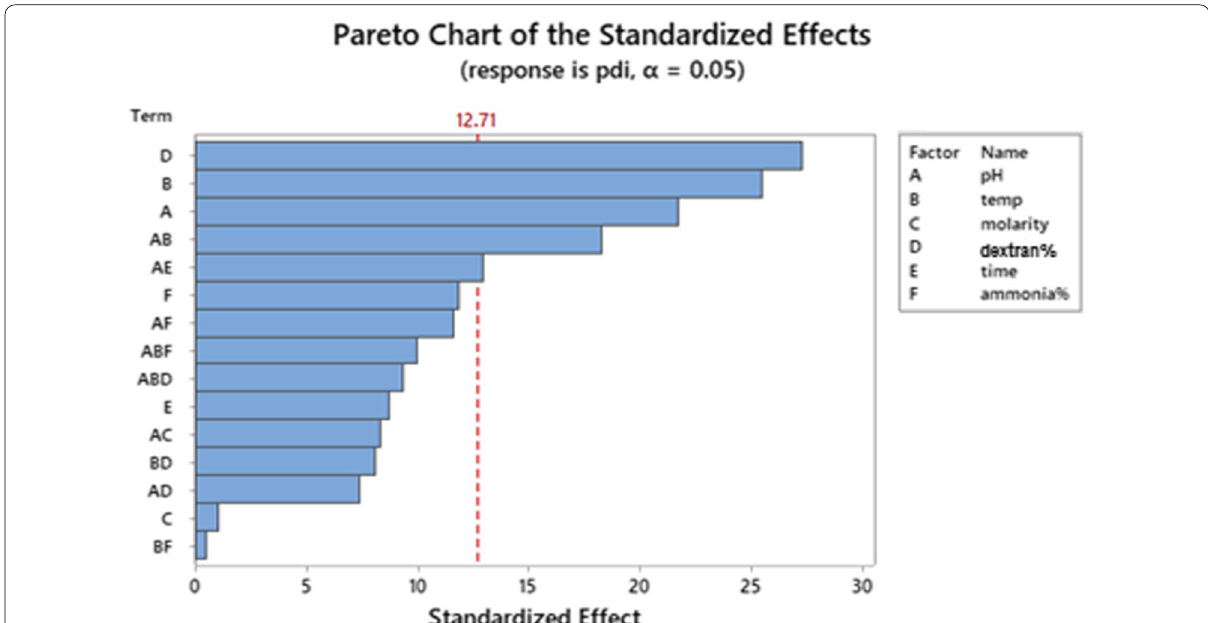
Fig. 1 Pareto chart showing analysis of results of fractional factorial design for preparation of MNPs using Minitab 2010, ver. 16.1.1, the result analysis indicated that the concentration of dextran solution had a significant effect on the PDI beside the pH and temperature of incubation, both had a significant effect on the